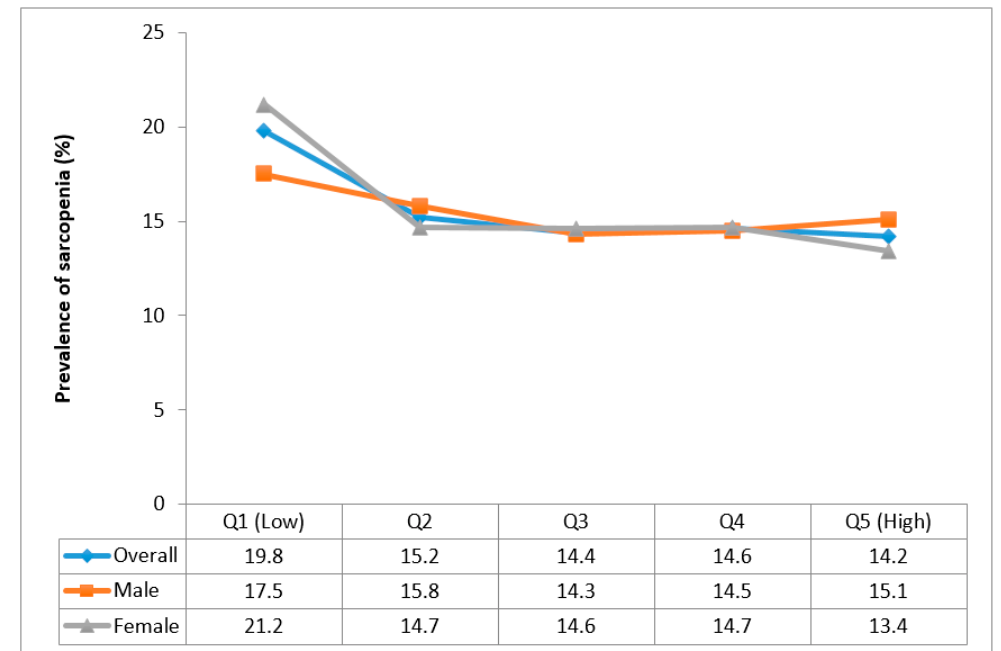
Figure 2. Prevalence of sarcopenia by quintiles of vegetable consumption.